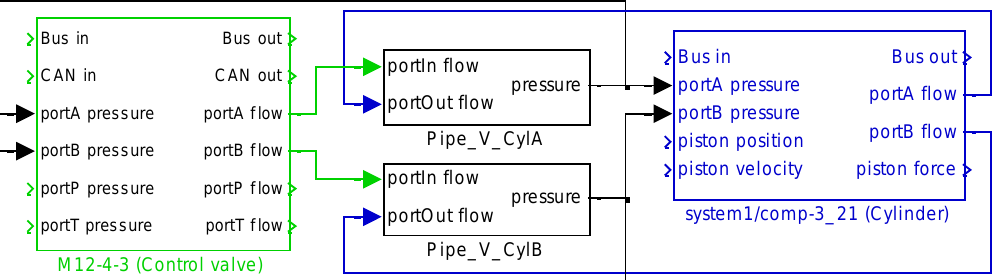
Figure 7. Excerpt of a simulation model in